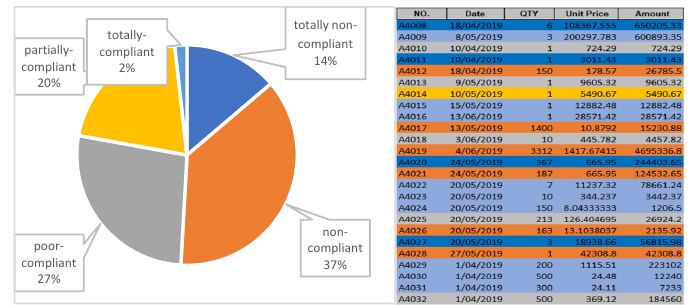
Figure 4. An example of purchasing audit report.